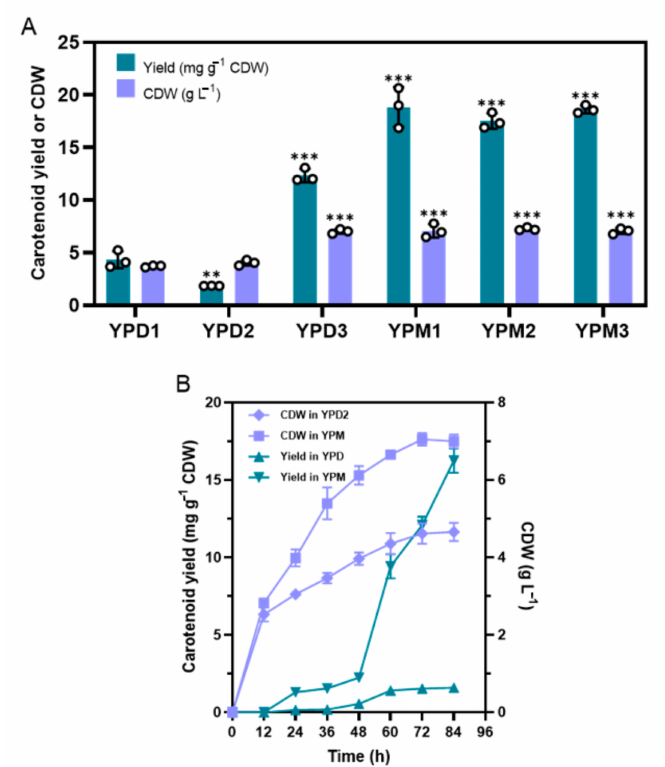
Figure 1. Carotenoid yields and cell masses when BL03-D-4 was cultivated for 96 h in YPD media with different yeast extractions or modified YPD (YPM) media ( A ). Time-courses of carotenoid fermentation in YPD2 and YPM media ( B ). YPD1, YPD media with yeast extraction of LOT: 2665431- 02. YPD2; YPD media with yeast extraction of LOT: 2315359-02. YPD3; and YPD media with yeast extraction from Angel (FM802, LOT: 2018082210C9). YPM1, YPM2, and YPM3 represented three replicates using YPM media along with YPD1, YPD2, and YPD3, respectively. The values are the means and standard deviations of three biological replicates (small circles). **: significantly different based on two-tailed Student’s t -test ( p < 0.01); ***: significantly different based on two-tailed Student’s t -test ( p <